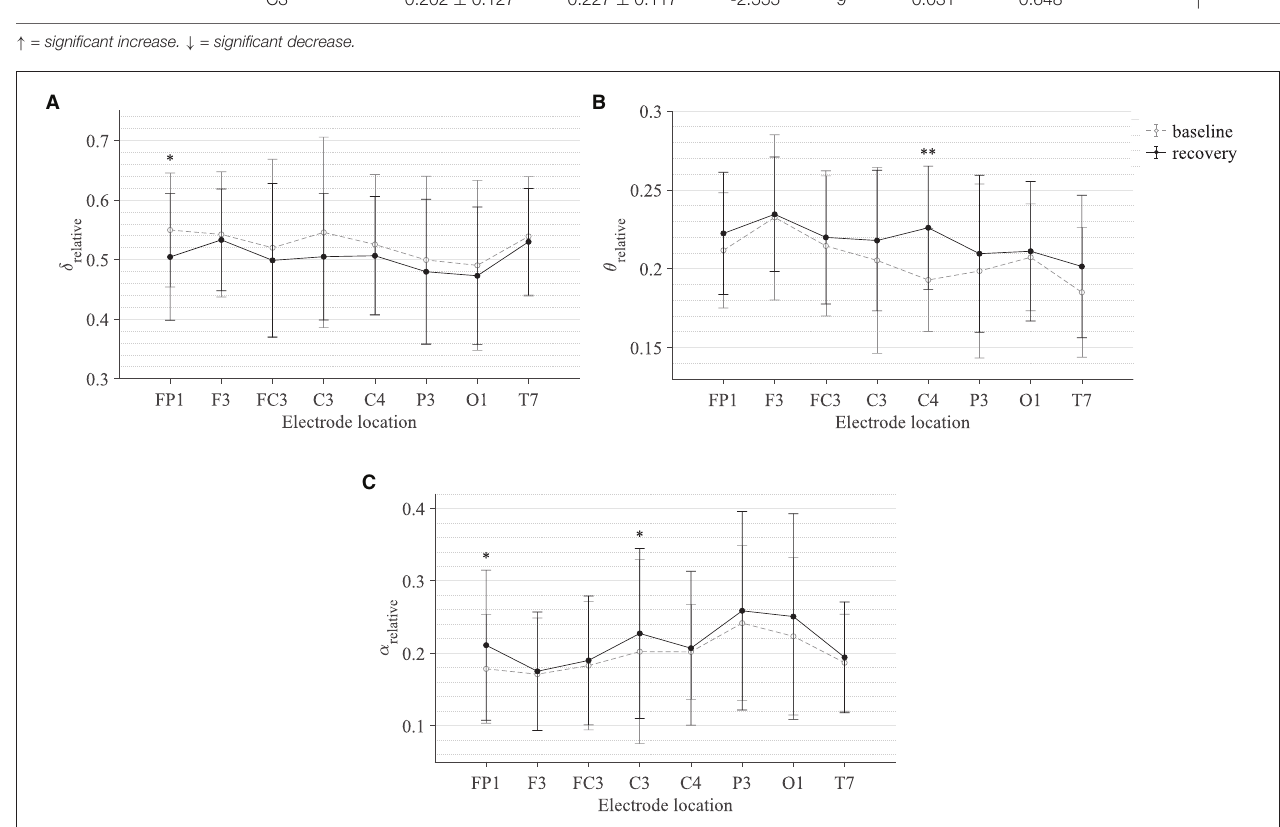
FIGURE 8 | Comparison of the sample mean and standard deviation of (A) δ relative , (B) θ relative , and (C) α relative of all participants between baseline and recovery states for the fine motor interaction with SCRIPT passive orthosis. The statistical significance is represented by an asterisk: i.e., *p < 0.05 and **p <